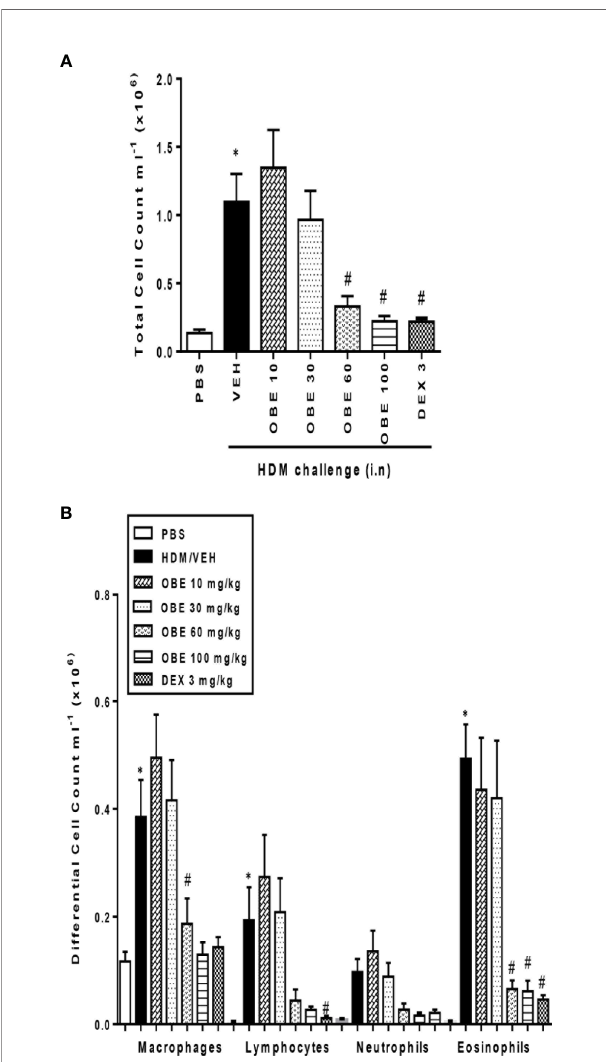
FIGURE 3 | Effect of OBE, 10, 30, 60, and 100 mg/kg (i.p.) on HDM-induced increase in (A) total cell and (B) differential cell count. OBE treatment resulted in a dose-dependent inhibition of total and eosinophil numbers. Data are expressed as mean ± SEM ( n = 9 – 15) *P < 0.05 vs PBS group, # P < 0.05 vs HDM group.